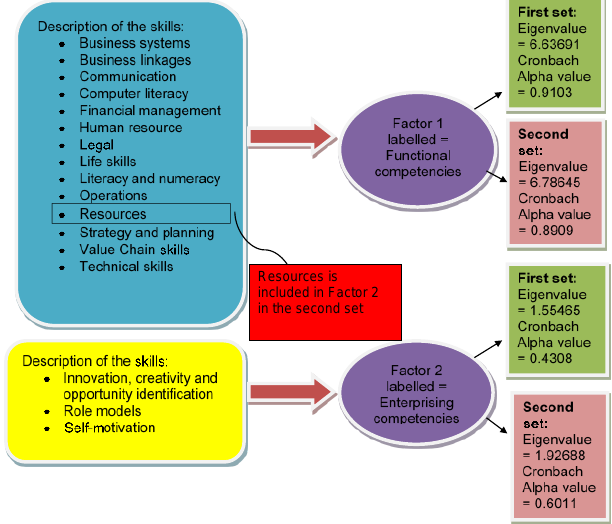
Figure 2: Observed factors as produced from EFA For the first set of variables testing the importance of the skills and competencies , the 17 items, posed on a three-point Likert scale, delivered an excellent Cronbach Alpha result. A value of 0.8854 was obtained for all the variables used. The Cronbach Alpha for factor 1 was acceptable at 0.9103, which indicated that the instrument actually measured the concepts aimed to be measured and signified internal consistency. The Cronbach Alpha for factor 2 was not acceptable as it was very low at 0.4308. Low Cronbach alphas indicate low validity and reliability of the factor. Normally, such a factor would be excluded in a research study. However, it was decided to include the second factor and accept the low Cronbach alpha because the second factor items were similar to the enterprising competencies category that was identified in the literature review. The low value of 0.4308 may be due to the small number of variables (Kim & Mueller, 1988). Factor 2